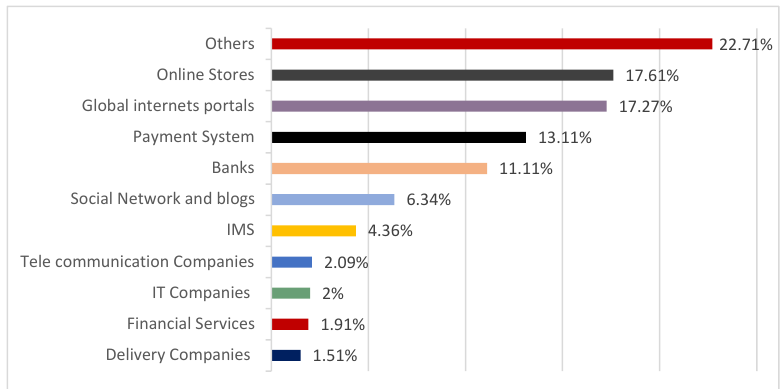
Figure 1. Percentage of phishing attack organisations.